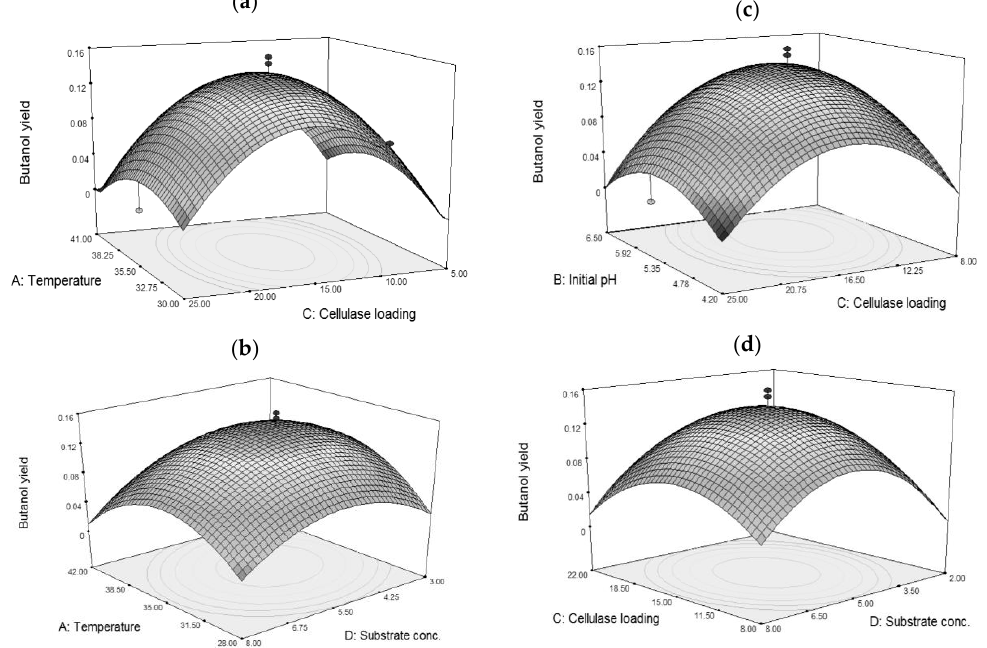
Figure 1. 3D-surface graphs for a model for biobutanol yield at the optimum point: ( a ) interaction between temperature and cellulase loading, ( b ) interaction of temperature and substrate concentration, ( c ) interaction of initial pH with cellulase loading, ( d ) interaction of cellulase loading with substrate concentration.